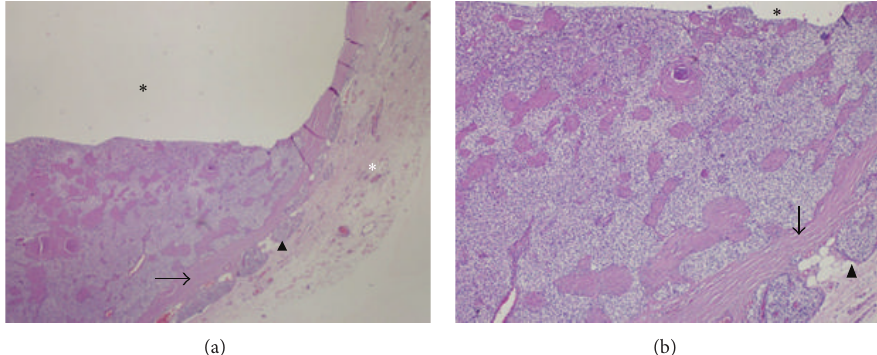
Figure 5: Parathyroid adenoma presenting cystic degeneration. Cystic lesion consisting of parathyroid cells separated from parathyroid gland with fibrous capsule. Note that the parathyroid parenchyma is squeezed in peripheral region of the lesion ((a) H&E × 40, (b) H&E × 100, black asterisk; cystic space, white asterisk; extraparathyroidal area, arrow; fibrous capsule, arrow head; squeezed parathyroid tissue).